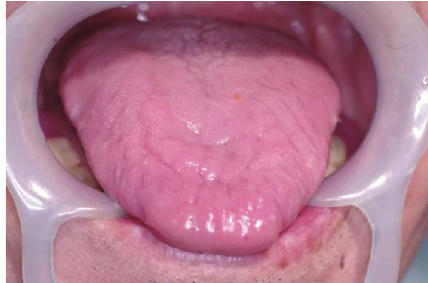
Figure 7: Postoperative intraoral view. At present, after surgery, the patient is in excellent condition, without recurrence and with improved